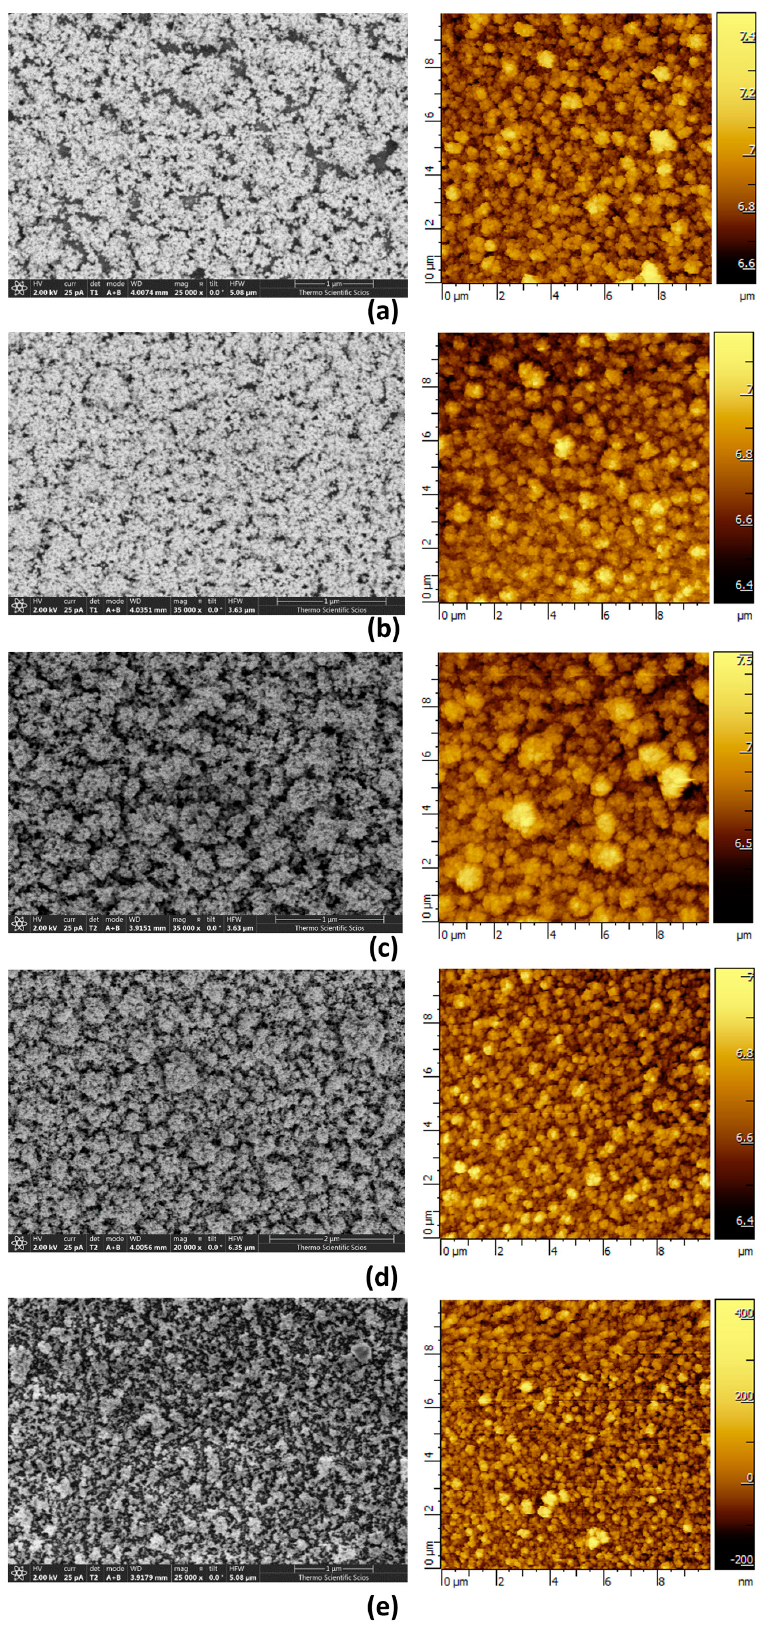
Figure 3. SEM ( left column ) and AFM ( right column ) images of S1 ( a ), S2 ( b ), S3 ( c ), S4 ( d ), and S5 ( e ).